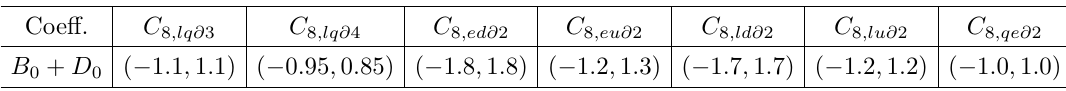
Table 4 . Profiled bounds on the dimension-8 coefficients for Λ = 2 TeV at the quadratic level obtained with the 2D differential information in B 0 and D 0